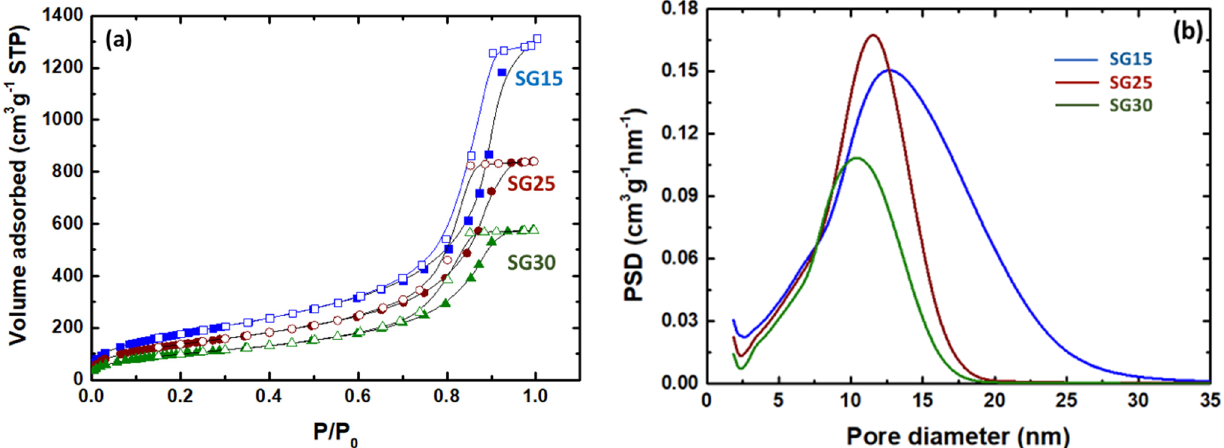
Figure 2. ( a ) N2–isotherms and ( b ) pore size distribution (PSD) of aerogels. (The full and open